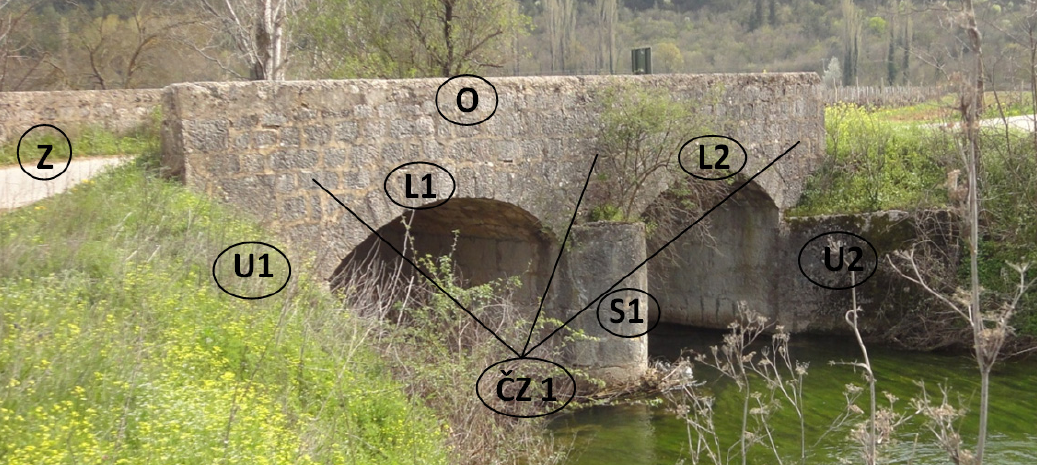
Figure 5. Labels of bridge elements for assessment (L1—arch1; L2—arch2; S—pier; U1—abutment1; U2—abutment2; Č Z1—the group1 of spandrel walls (a view from west side); Z—pavement; O—fence).